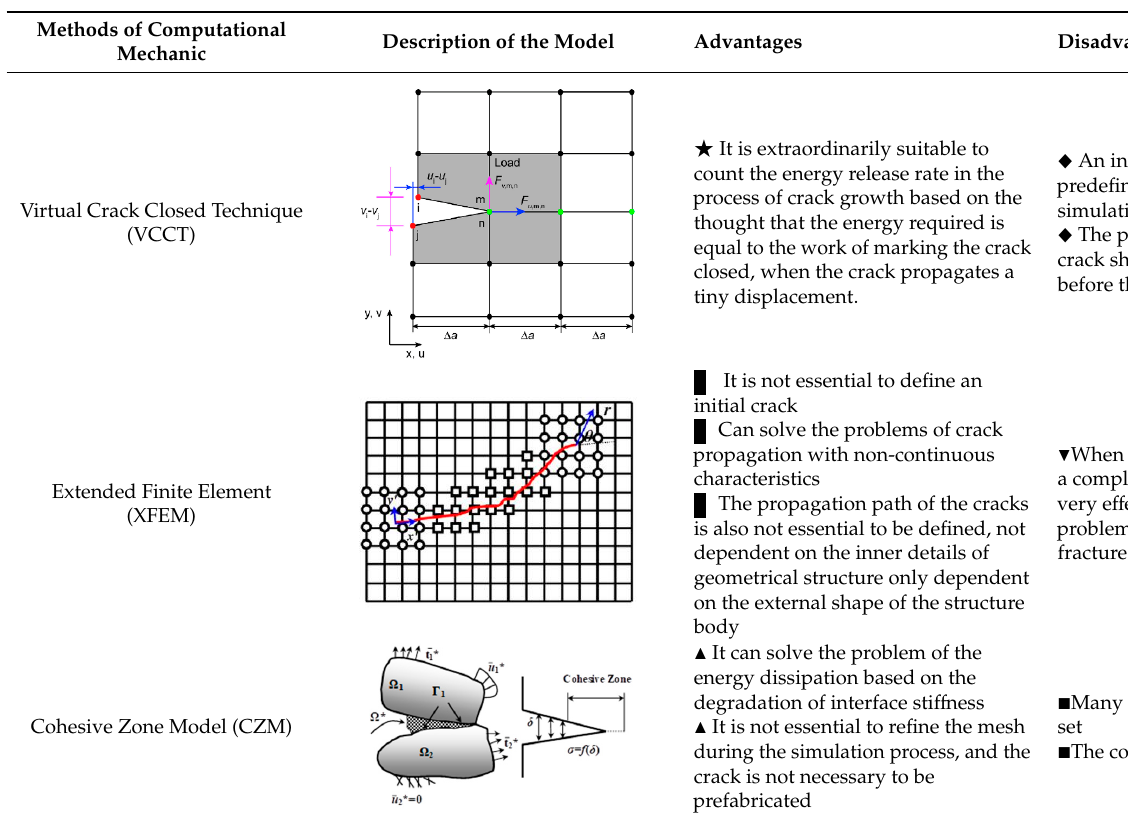
Table 2. Comparison of VCCT, XFEM, and CZM.